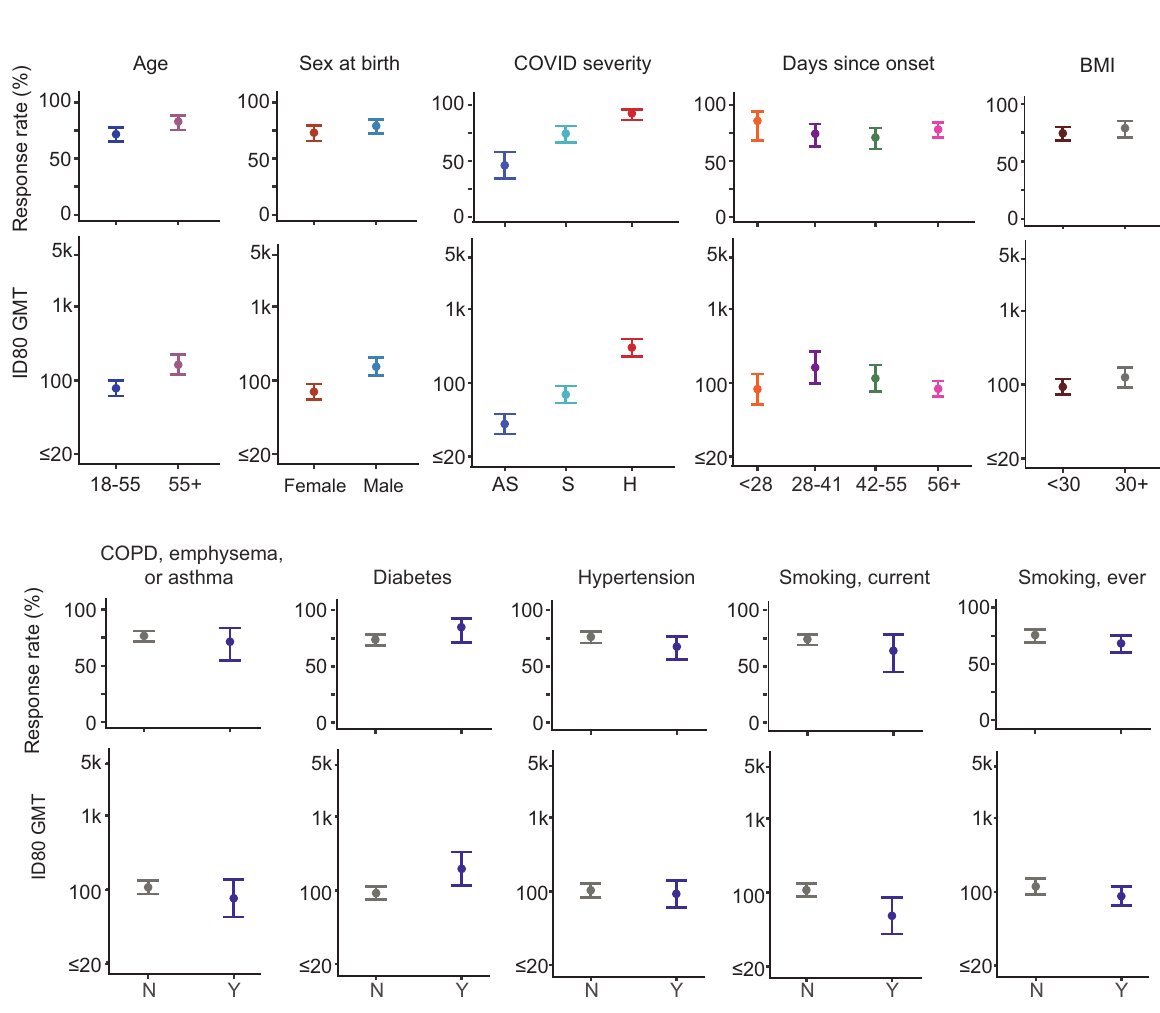
assigned female sex at birth with GMT of 701 versus 354 for ID50 and 152 versus 70 for ID80 ( Table C in S1 Data ); titers were over 1.5 times higher after adjusting for other factors (ID50, p = 0.042, q = 0.092; ID80, p = 0.004, q = 0.014; Table 2 ). Similar increases were observed in the model adjusting for study design–specific variables only, though were not significant at in S1 Data ). However, those assigned male sex at birth did not exhibit significantly higher rates of nAb responses than those assigned female sex at birth (ID50: 85% versus 86%; ID80: 79% versus 73%) ( Table 2, Tables A and D in S1 Data ). As observed with nAb response differences by age, the differences in nAb titers between those assigned male and those assigned female sex at birth were not evident among asymptom- atic individuals (ID50: GMR = 0.53, p = 0.14; ID80: GMR = 0.84, p = 0.6); they were also not evident in symptomatic outpatients (ID50: GMR = 1.53, p = 0.18; ID80: GMR = 1.56, p = 0.06) but were evident in those who were hospitalized (ID50: GMR = 2.41, p = 0.005, q = 0.008;